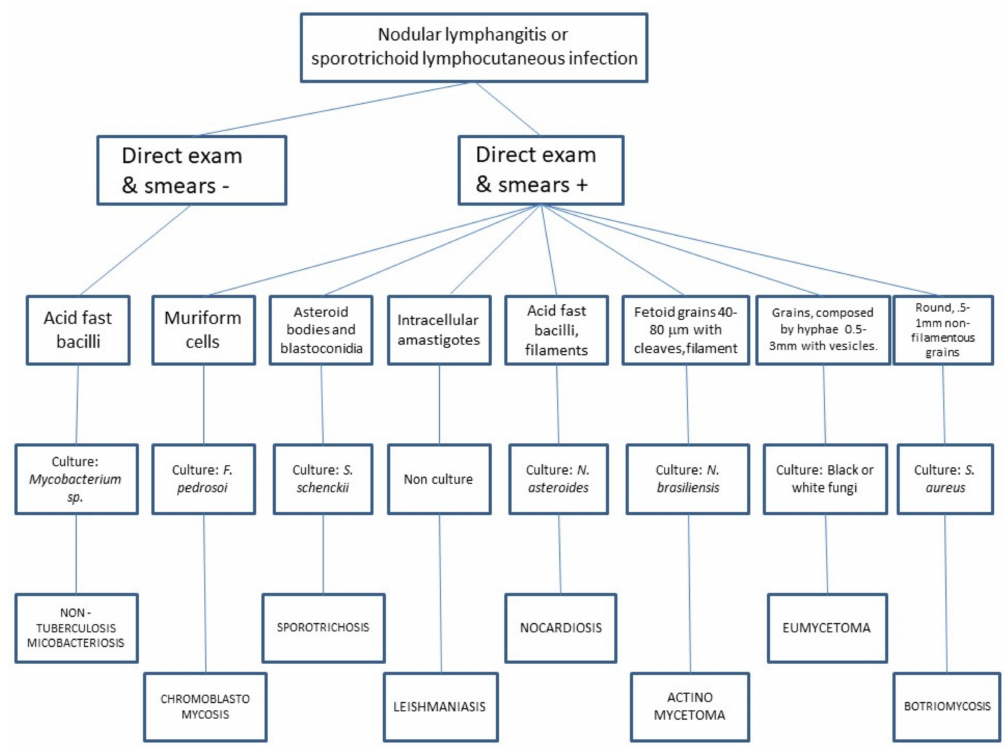
Figure 1. Algorithm proposal for diagnostic approach in nodular